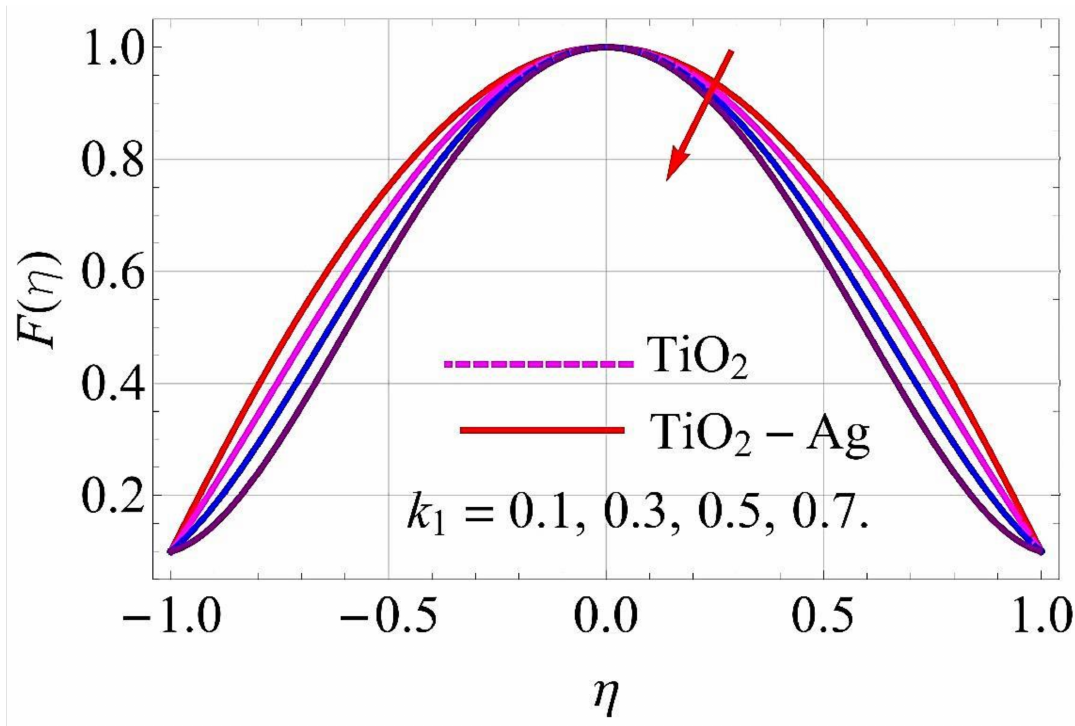
Figure 7. Velocity versus k 1 with α = − 5 ◦ for converging/stretching circumstances. When Re = 25, φ 1 = φ 2 = 0.01, Rd = 0.4, Ec = Q = Fr = k ∗ = Ha = 0.1.